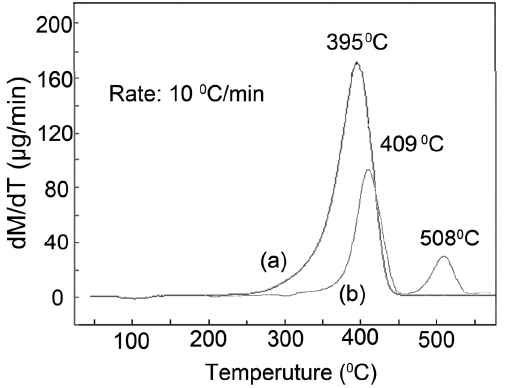
Figure 15. DTG curves of (a) PS, (b) PS/Sb 2 O 3 -Br com- pound.